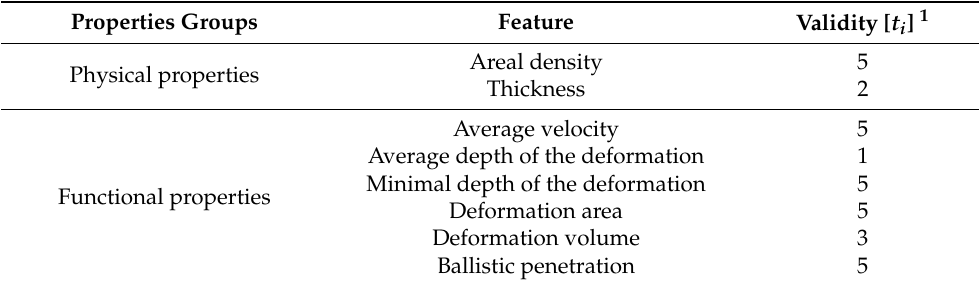
Table 5. Validity of the groups of properties of HBP being the criteria for the selection of the optimal HBP